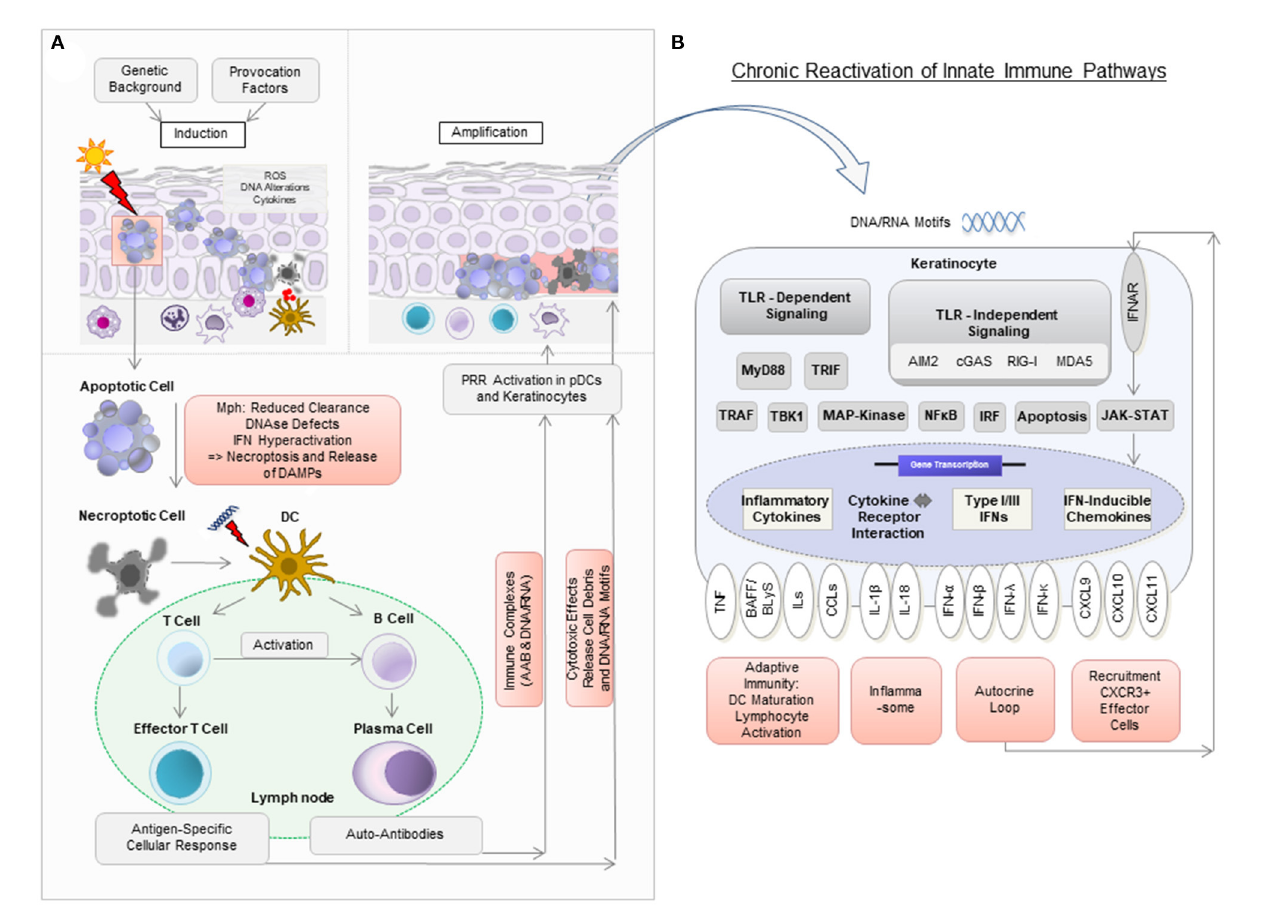
FIGURE 1 | Model of pathogenic mechanisms in cutaneous lupus erythematosus (CLE). (A) In a person with a genetic background predisposing to CLE, the exposure to provocation factors such as UV light can induce cellular stress [reactive oxygen species (ROS), DNA alterations, cytokine secretion], apoptosis, and the release of DNA components in so-called “apoptotic blebs” in keratinocytes. Normally, these “blebs” are rapidly degraded and apoptotic cells are removed by macrophages (Mph). In CLE, delayed degradation and clearance leads to secondary, more pro-inflammatory, forms of cell death such as necroptosis, which results in the release of cell debris. Dendritic cells (DC) recognize this debris as potential autoantigens and migrate to nearby lymph nodes to present it to T and B cells. Upon activation, naïve B cells develop into plasma cells to produce autoantibodies (AAB). AAB form immune complexes with nucleic acids and can induce type I IFN production in plasmacytoid dendritic cells (pDCs). T cells mature into CD4 + and CD8 + T cells, with the latter exerting cytotoxic effects against keratinocytes. (B) Nucleic acids (DNA and RNA motifs) released from dying cells can be recognized by pattern recognition receptors (PRR) as so-called damage-associated